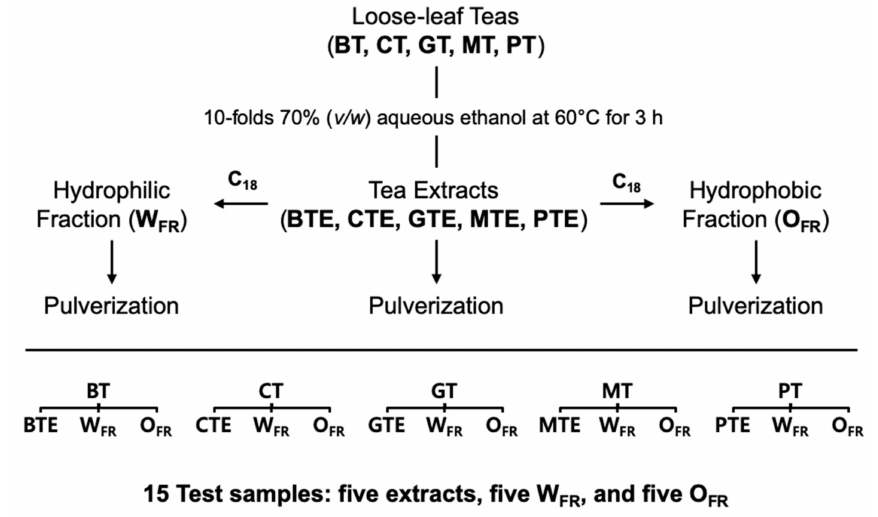
Figure 1. Method of preparing tea extracts and fractions. BT, black tea; CT, co-oxidized green tea, GT, green tea; MT, microbial fermented green tea; PT, post-fermented green tea; BTE, BT extract; CTE, CT extract, GTE, GT extract; MTE, MT extract; and PTE, PT extract. C 18 means reverse-phase octadecyl-silica